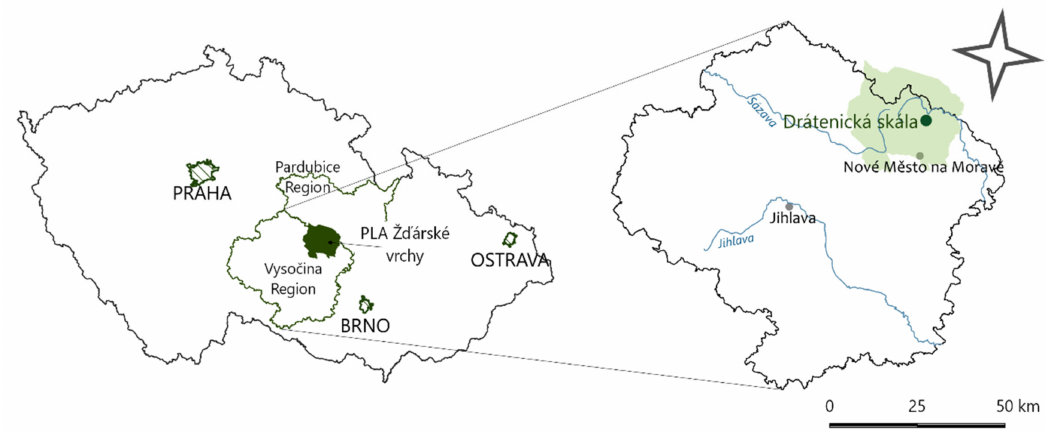
Figure 1. Localisation of Dr á tenick á sk á la within the Czech